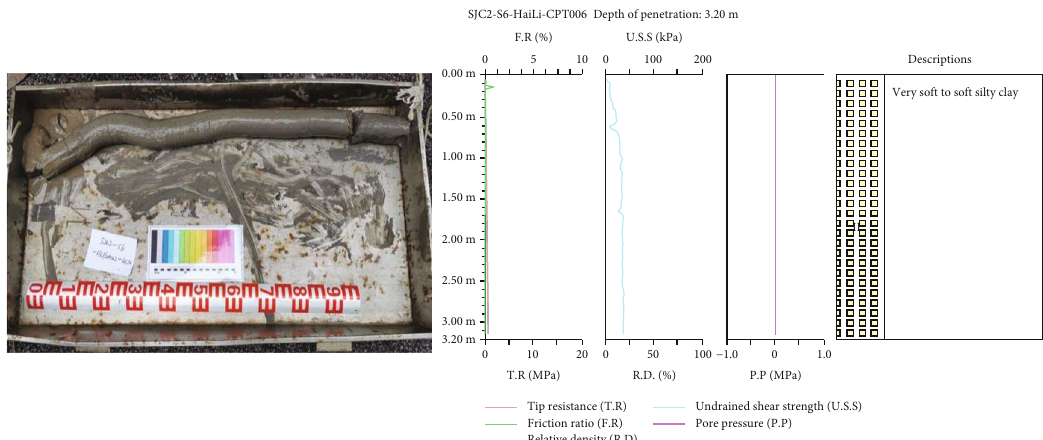
Figure 11: Sediment and CPT results in a typical erosion depression geomorphic area.